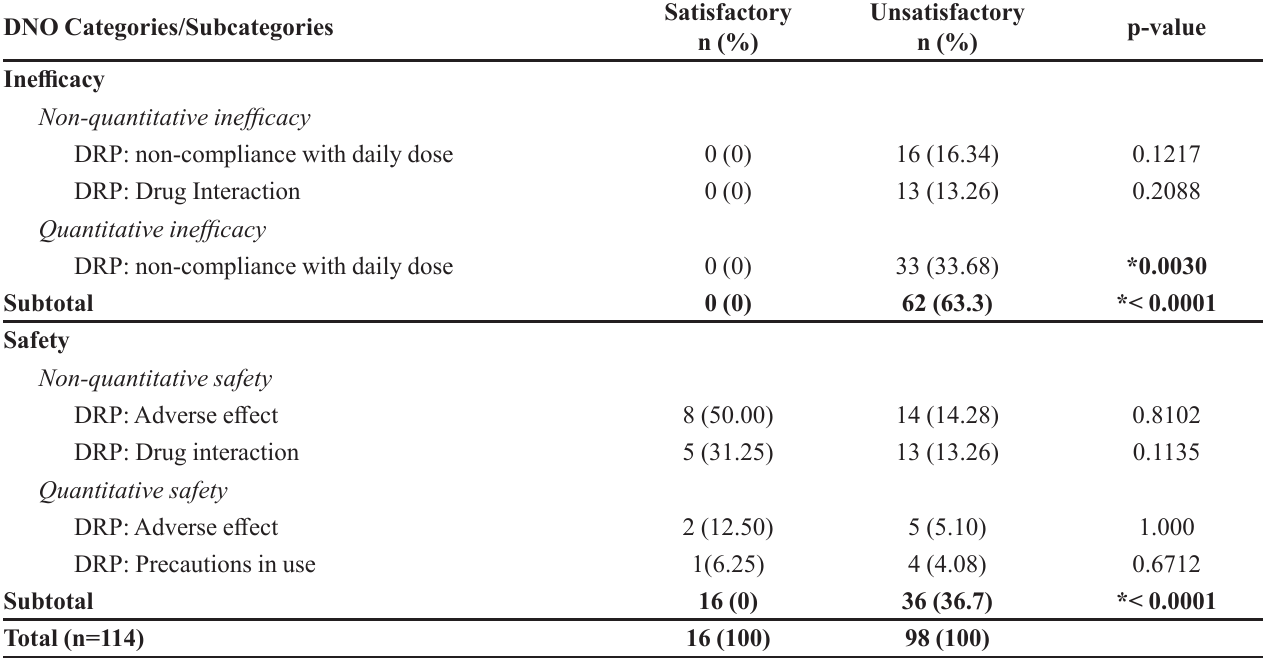
TABLE III - Antidiabetic drug-related negative outcomes according to glycemic control DNO